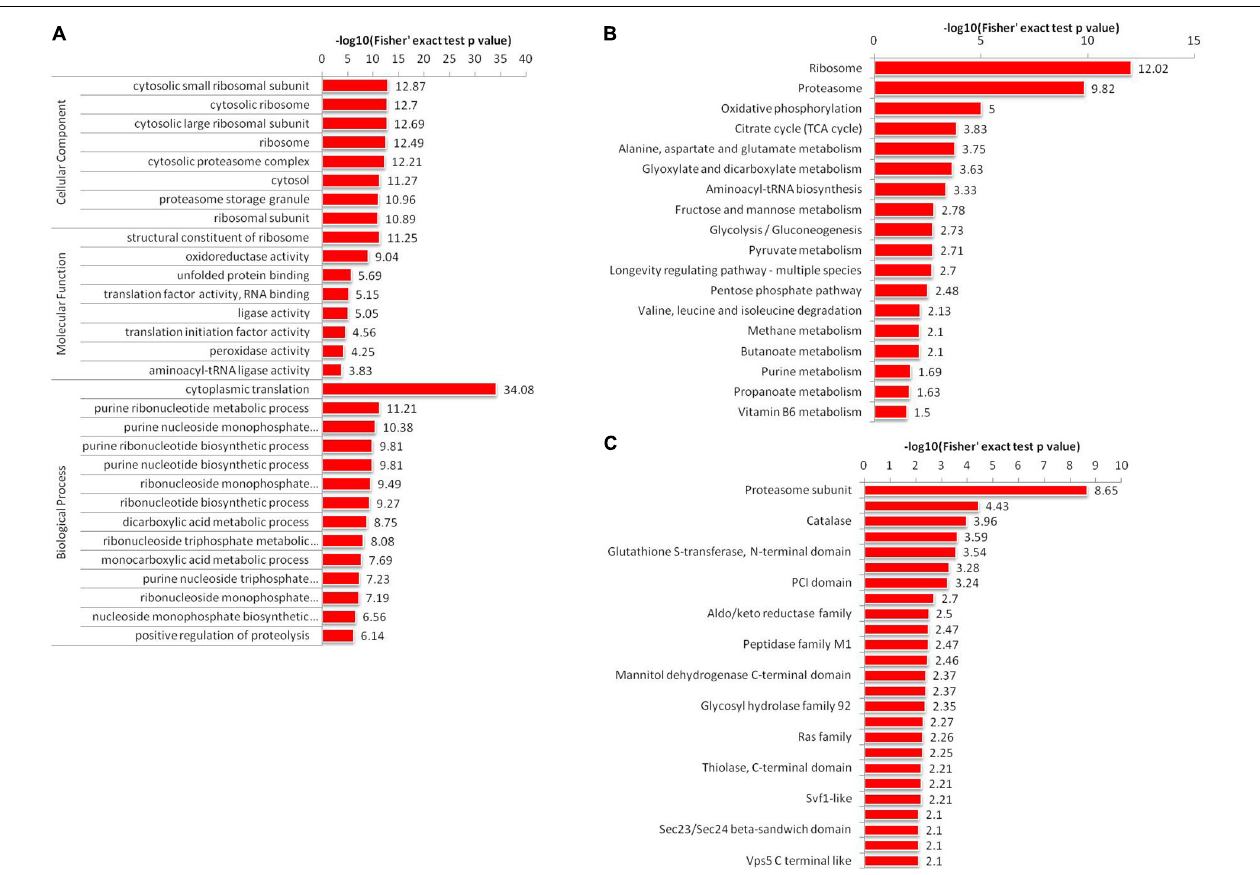
FIGURE 4 | Enrichment analysis of 2-hydroxyisobutyrylated proteins in A. niger . (A) GO-based enrichment analysis of identified proteins. (B) KEGG pathway-based enrichment analysis. (C) Protein domain enrichment analysis of all identified proteins.